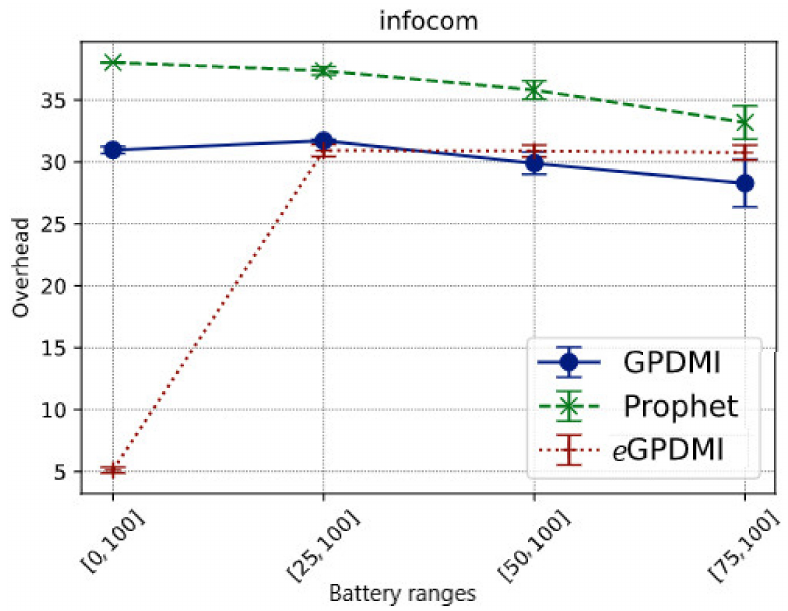
Figure 5. Network overhead vs. battery ranges in Infocom